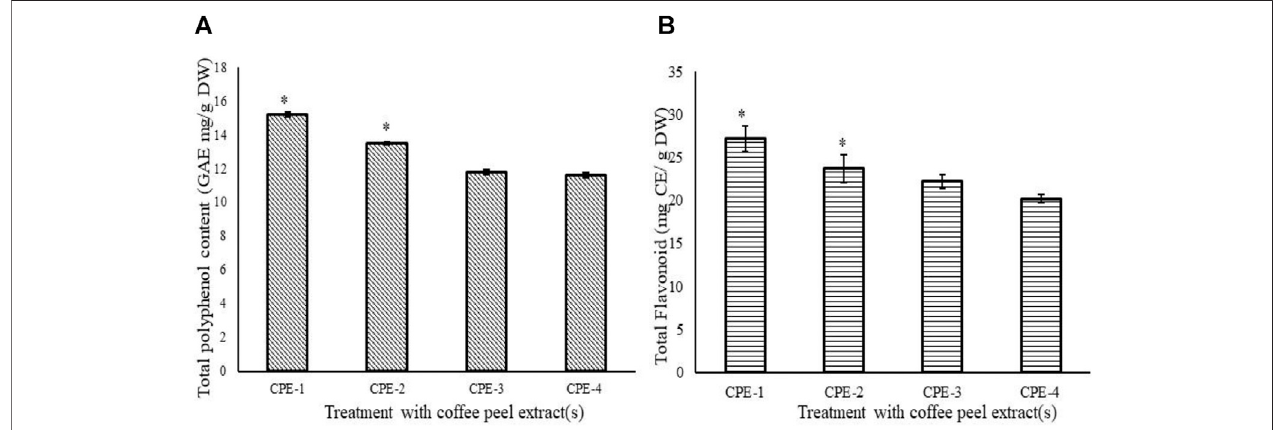
FIGURE1| TPC(GAEmg/gDW) (A) and fl avonoid(mgCE/gDW) (B) inCPEs(CPE-1 (cid:1) 0.5 g,CPE-2 (cid:1) 0.75 g,CPE-3 (cid:1) 1 g,andCPE-4 (cid:1) 1.25 g).Allthevaluesare expressed as mean ± SD and are signi fi cantly different at * p ≤ 0.05.